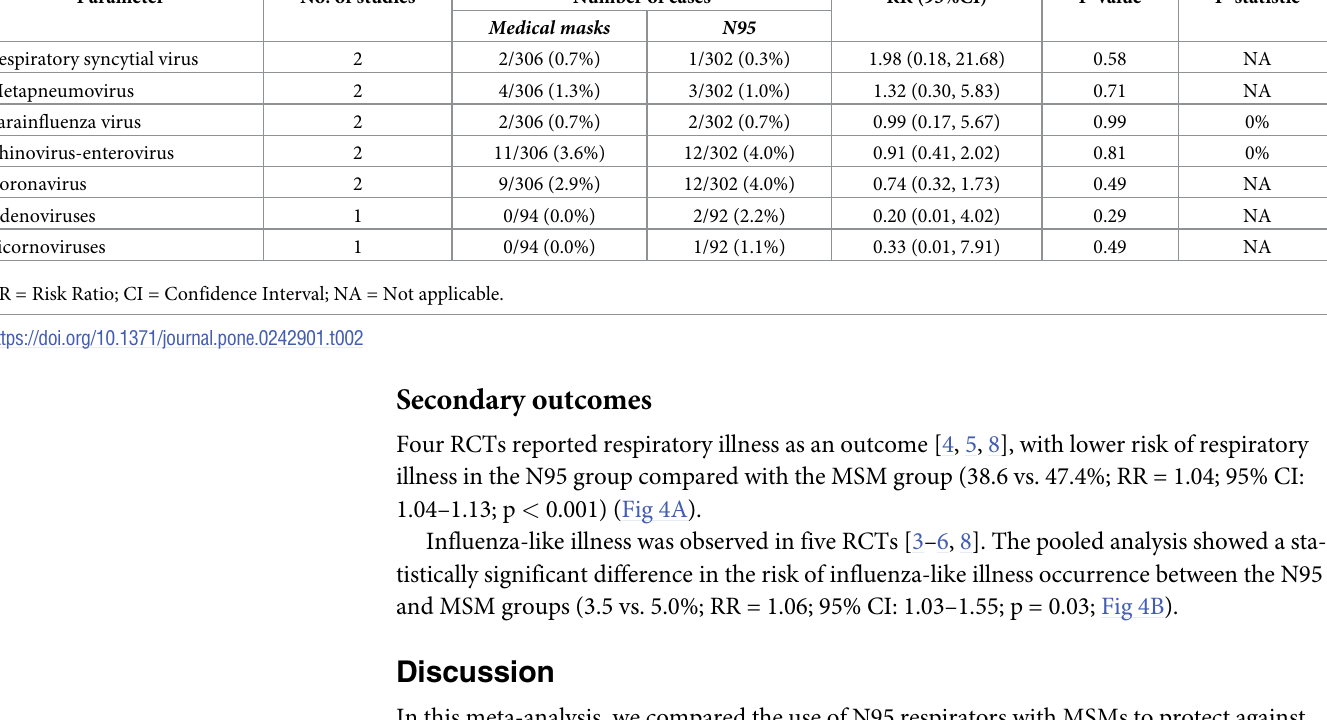
Table 2. Data of laboratory-confirmed other respiratory viruses in medical masks vs. N95 groups. Parameter